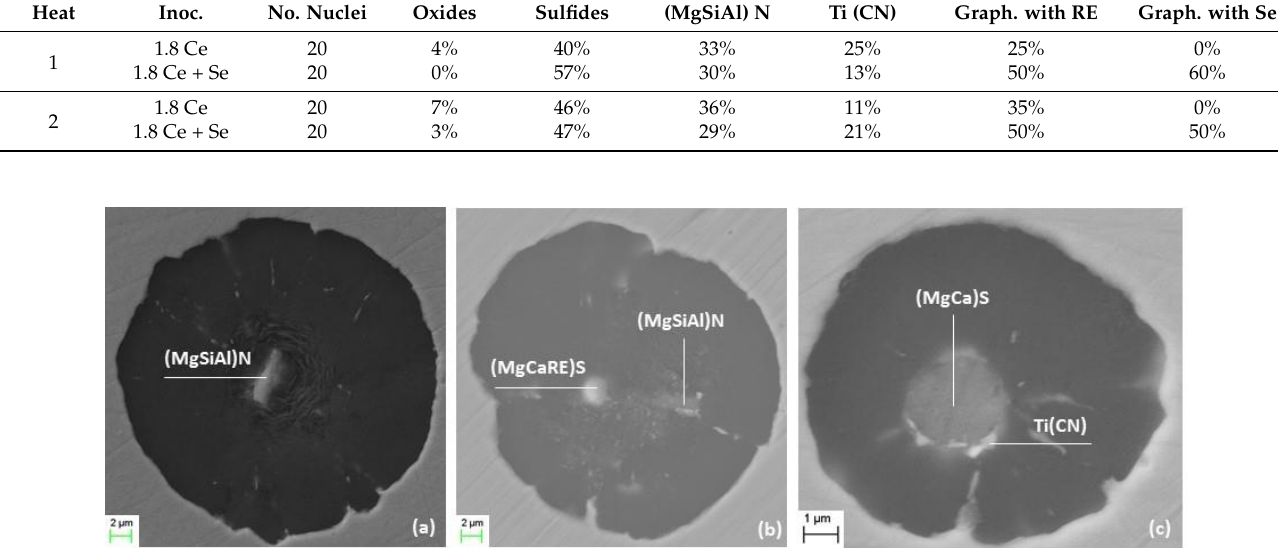
Figure 10. Different nonmetallic inclusions acting as nucleation sites for the graphite: ( a ) a complex Mg-Si-Al nitride; ( b ) a combination of (MgSiAl) N + (MgCaRE) S; ( c ) a small Ti (CN) growing on a big Mg-Ca sulfide.